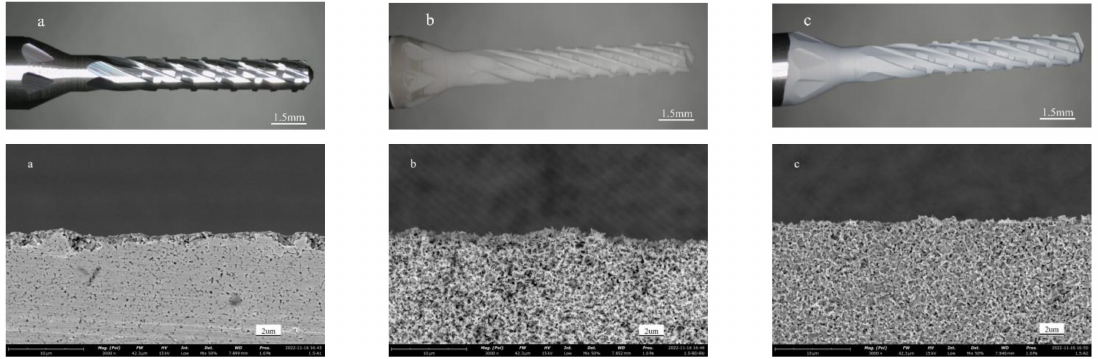
Figure 2. Surface morphology of tool substrate before and after pretreatment. ( a ) Unprocessed; ( b ) Alkali etching for 20 min; ( c ) Acid etching for 10